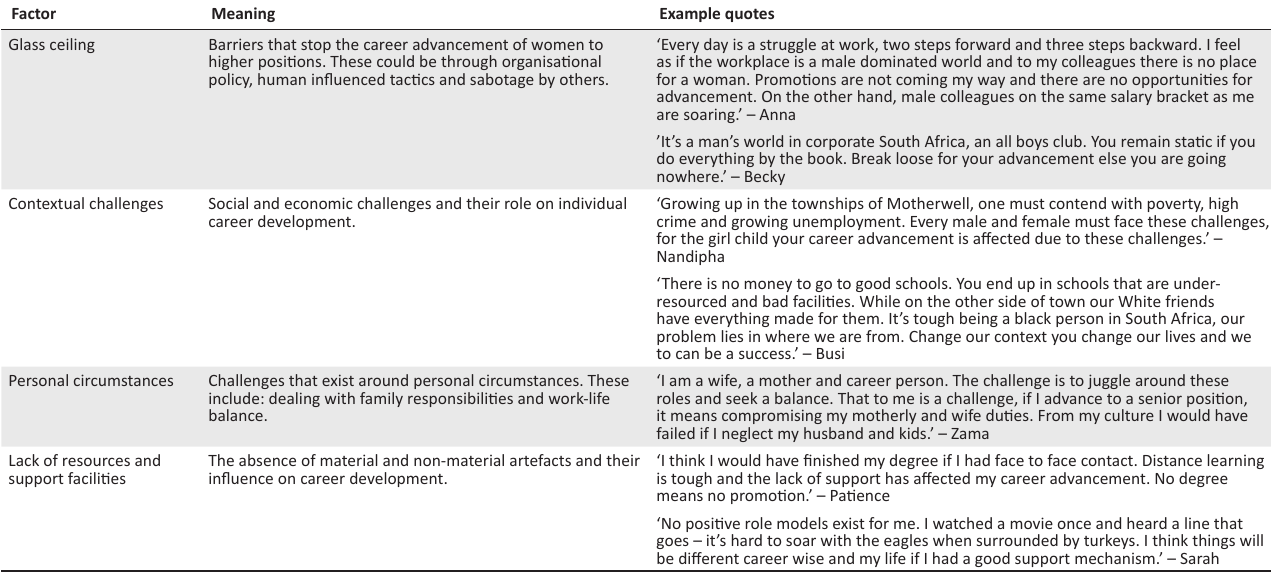
TABLE 5: Summary of factors perceived to impede career success. Factor